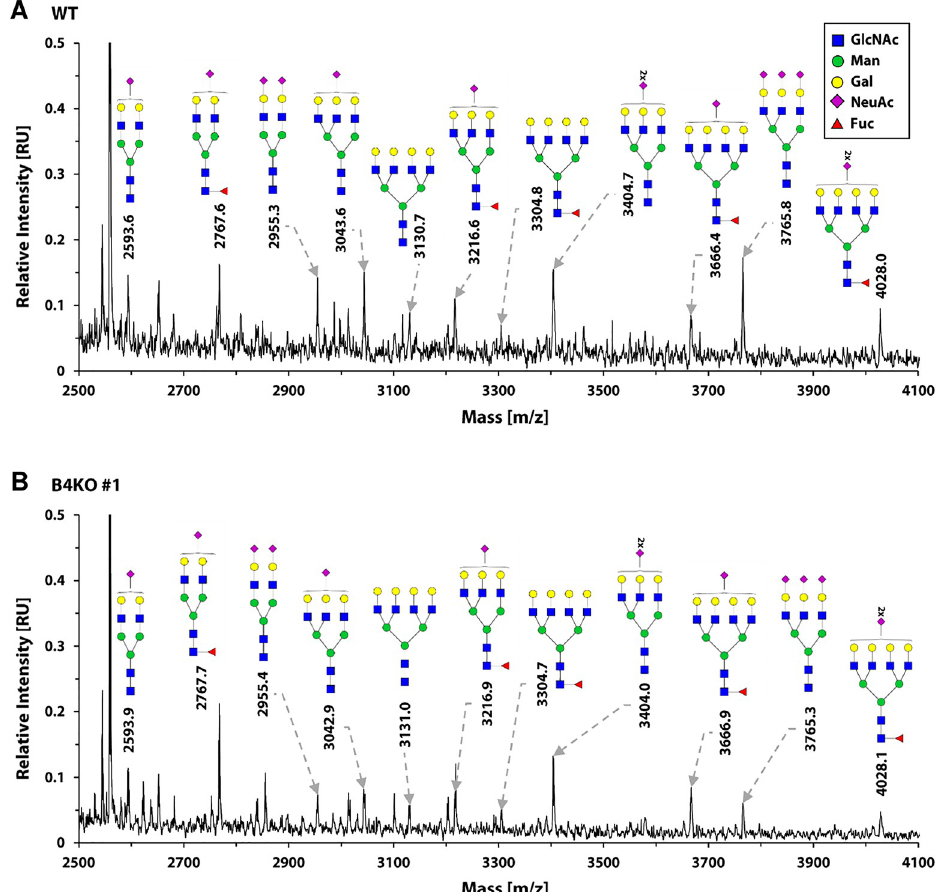
Fig 12. Analysis of N -glycans structures in the wild-type and SLC35B4 knock-out HepG2 cells. MALDI-TOF-MS characterization of permethylated 2-AB- N -glycans purified from wild-type (WT) (A) and SLC35B4-deficient (B4KO) (B) HepG2 cells. Spectra were offset and scaled. For clarity of presentation mass region was restricted to 2500–4100 Da to contain complex-type N -glycans only. Identified peaks were labeled with mass information and cartoon representations of putative N -glycan chemical structures (based on biosynthetic knowledge). Identification of phosphorylated or sulfated glycans was not attempted. All variations of differently branched and sialylated complex- type N -glycans detected in the wild-type cells were also detected in SLC35B4 knock-out clones showing that N - glycosylation profile was not affected. Representative data from two independent experiments are